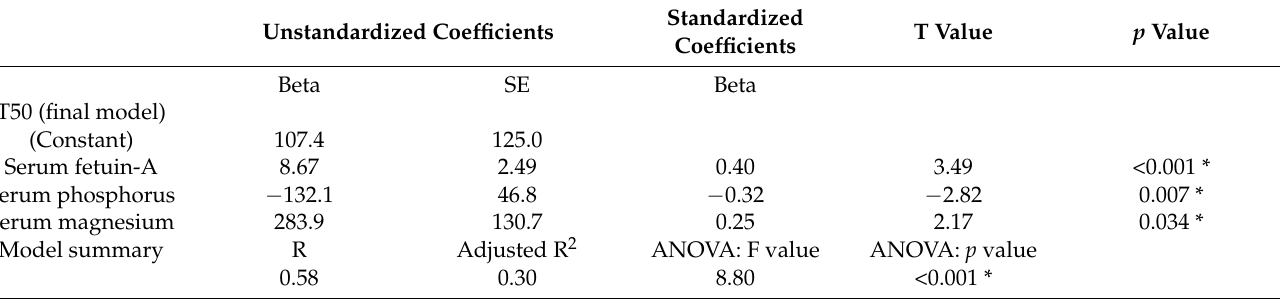
Table 2. Multivariate model of determinants of serum calcification propensity T50 in PXE. Age, serum phosphorus and serum magnesium levels were independent determinants of T50 in PXE patients. ANOVA—analysis of variance; SE—standard error. * p <